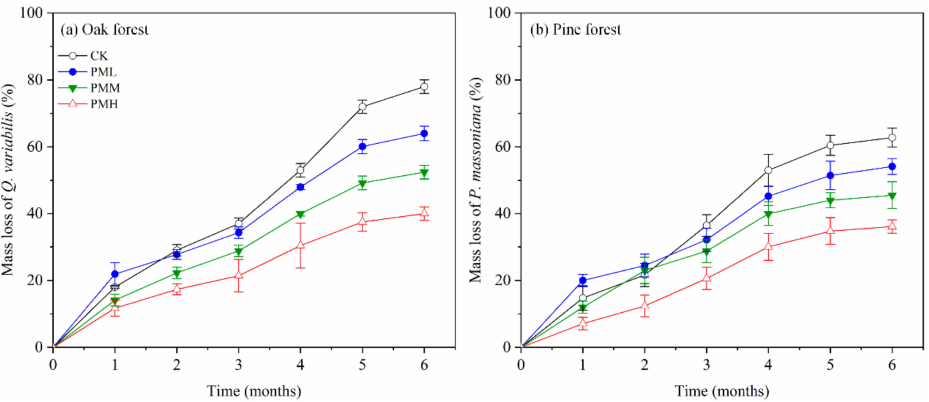
Figure 1. The mass loss of (a) oak and (b) pine leaf litters under di ff erent treatments during the six-month decomposition. Abbreviations: CK—control; PML—low concentration WSII–PM 2.5 ; PMM—medium